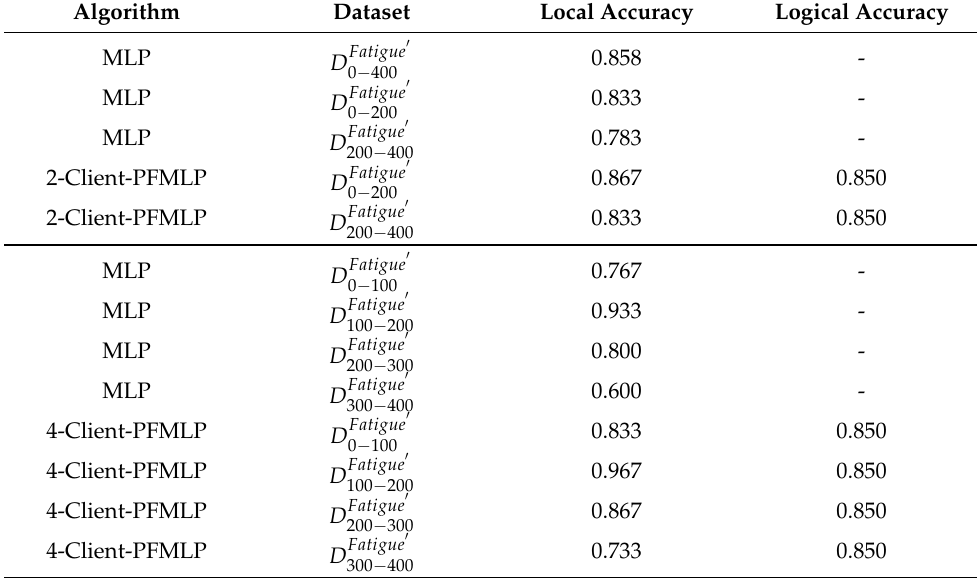
Table 8. The accuracy of PFMLP with different learning clients on the metal fatigue